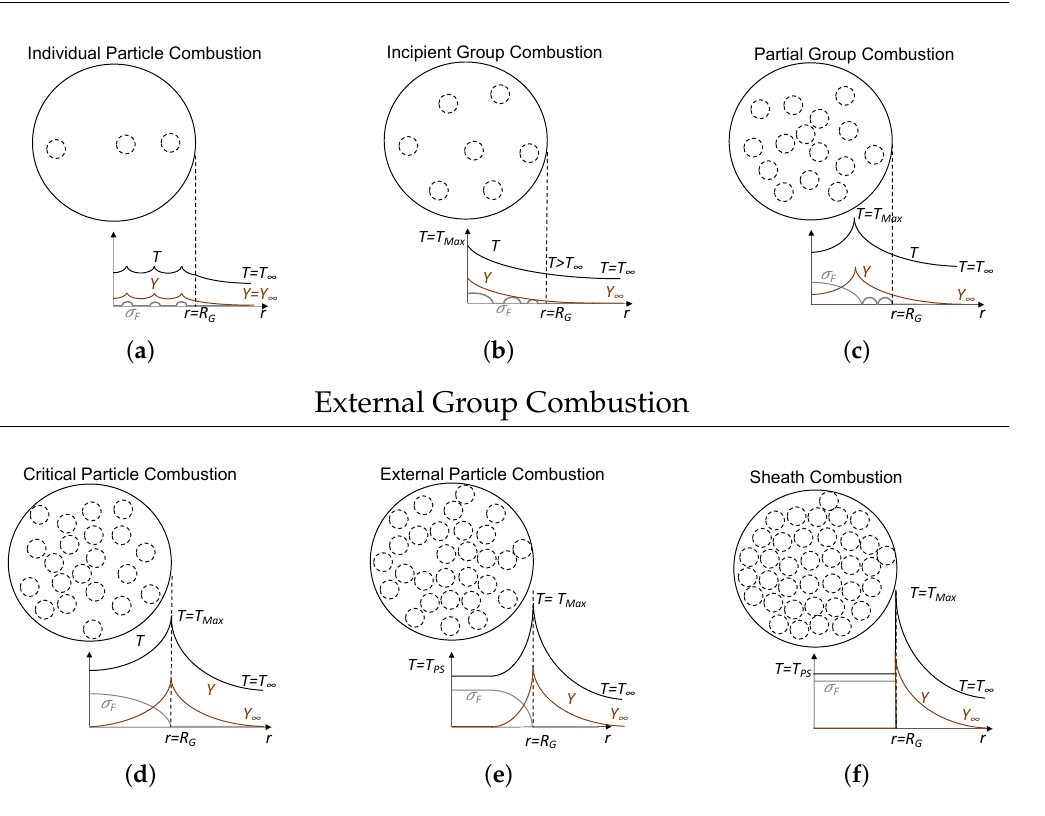
Figure 8. Illustration of minor group combustion modes for a cluster of nanothermites. T PS is the particle surface